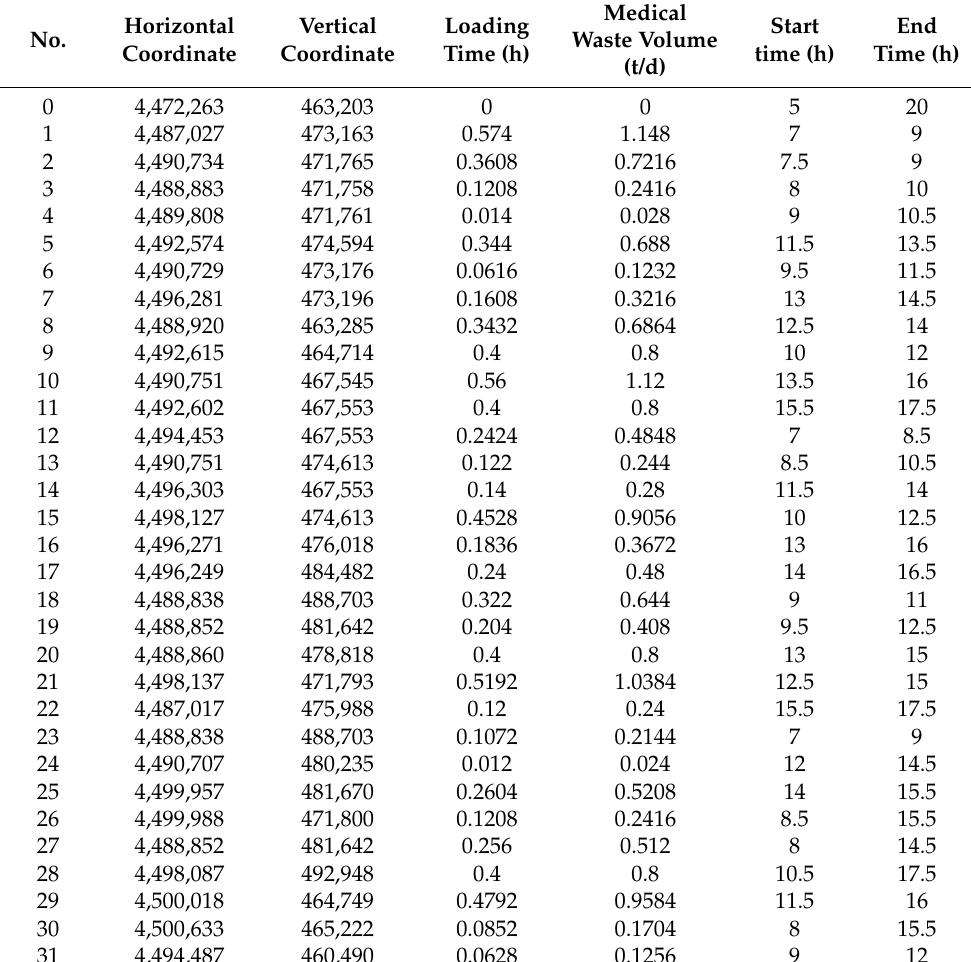
Table 5. The coordinates, loading time, daily waste production, and time window of the selected